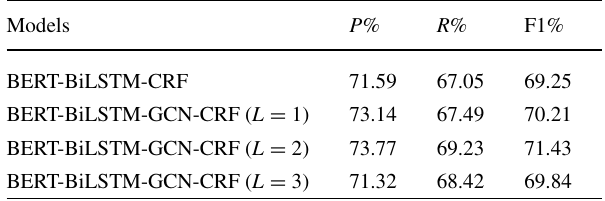
Table 6 Contribution of syntactic features to model performance